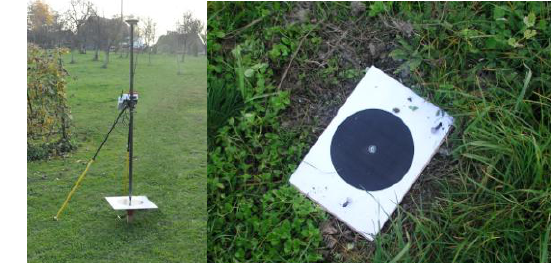
Figure 3. Example of